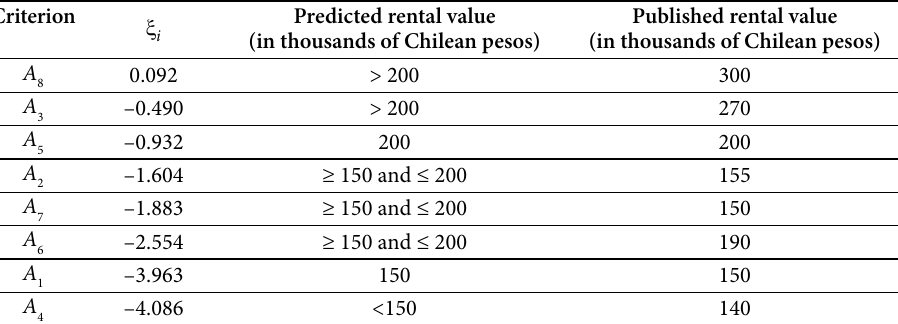
Table 3. Alternatives ordering (θ =